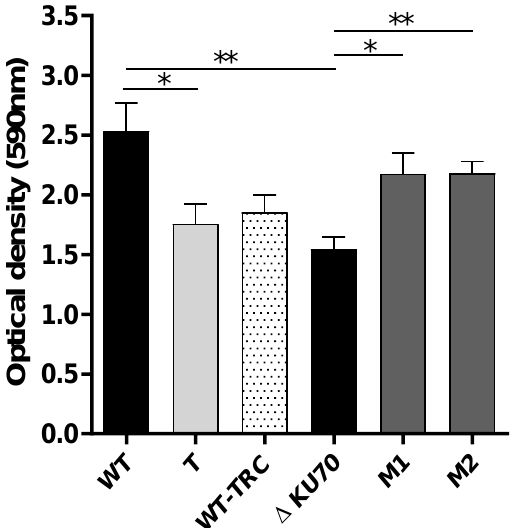
Figure 7. Biofilm formation. The total biomass was monitored using a crystal violet assay. Results from three independent experiments are shown. Significant differences are indicated as follows: * p < 0.05, ** p < 0.01 (Kruskall-Wallis test). T: transformant derived from the WT strain; M1 and M2: transformants derived from the ∆ KU70